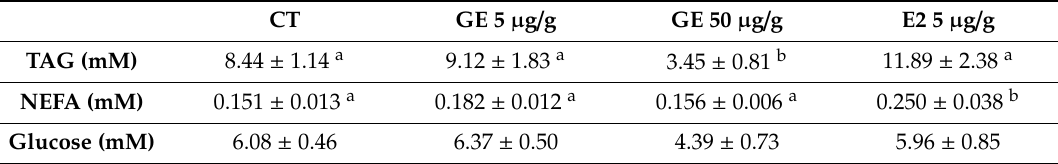
Table 1. Biochemical plasma parameters of rainbow trout intraperitoneally injected with genistein (GE) or 17 β -estradiol (E2).